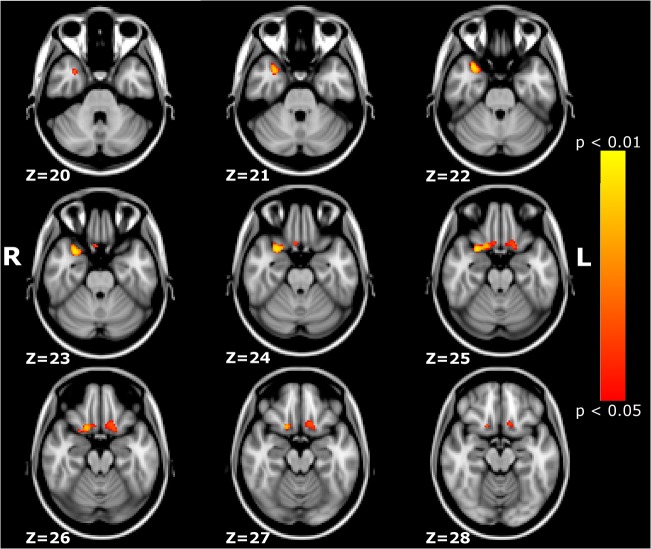
VBM results.Brain areas showing significant GM increases, including the right temporal pole and bilateral orbital frontal cortex (p < 0.05, corrected for multiple comparisons).